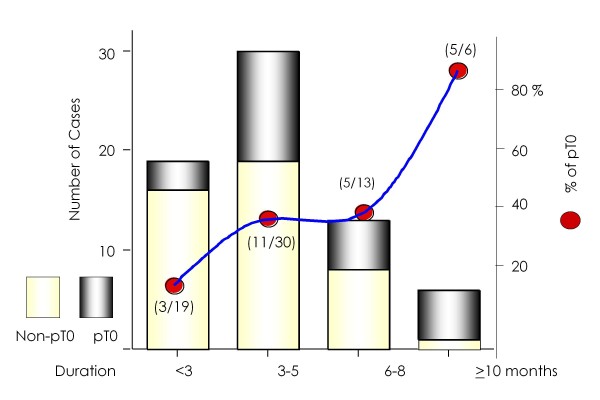
Number and frequency of pT0 according to duration of ADT after PSA reached < 0.2 ng/ml or its nadir.